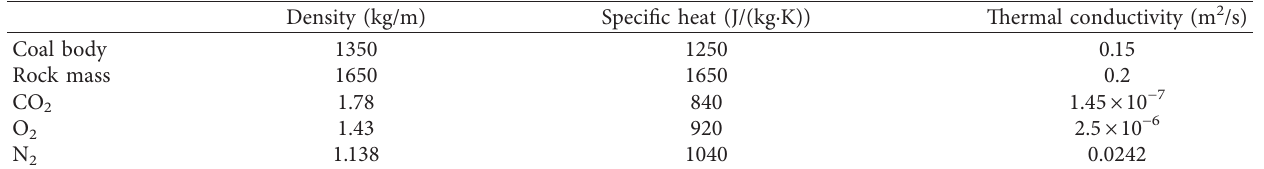
Table 4: Values of density, specific heat, and thermal conductivity for model materials.